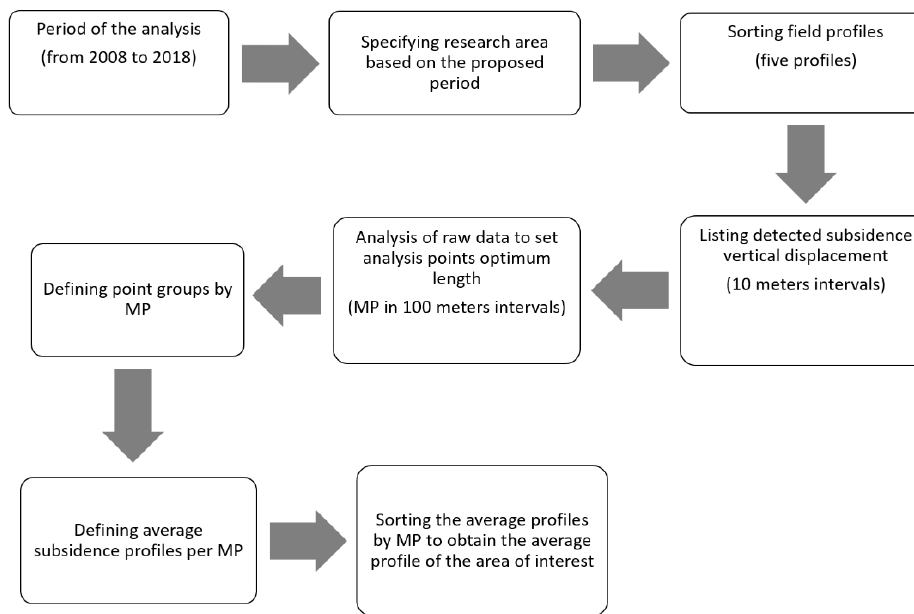
Figure 3. The methodology followed to reach the average surface subsidence profile.